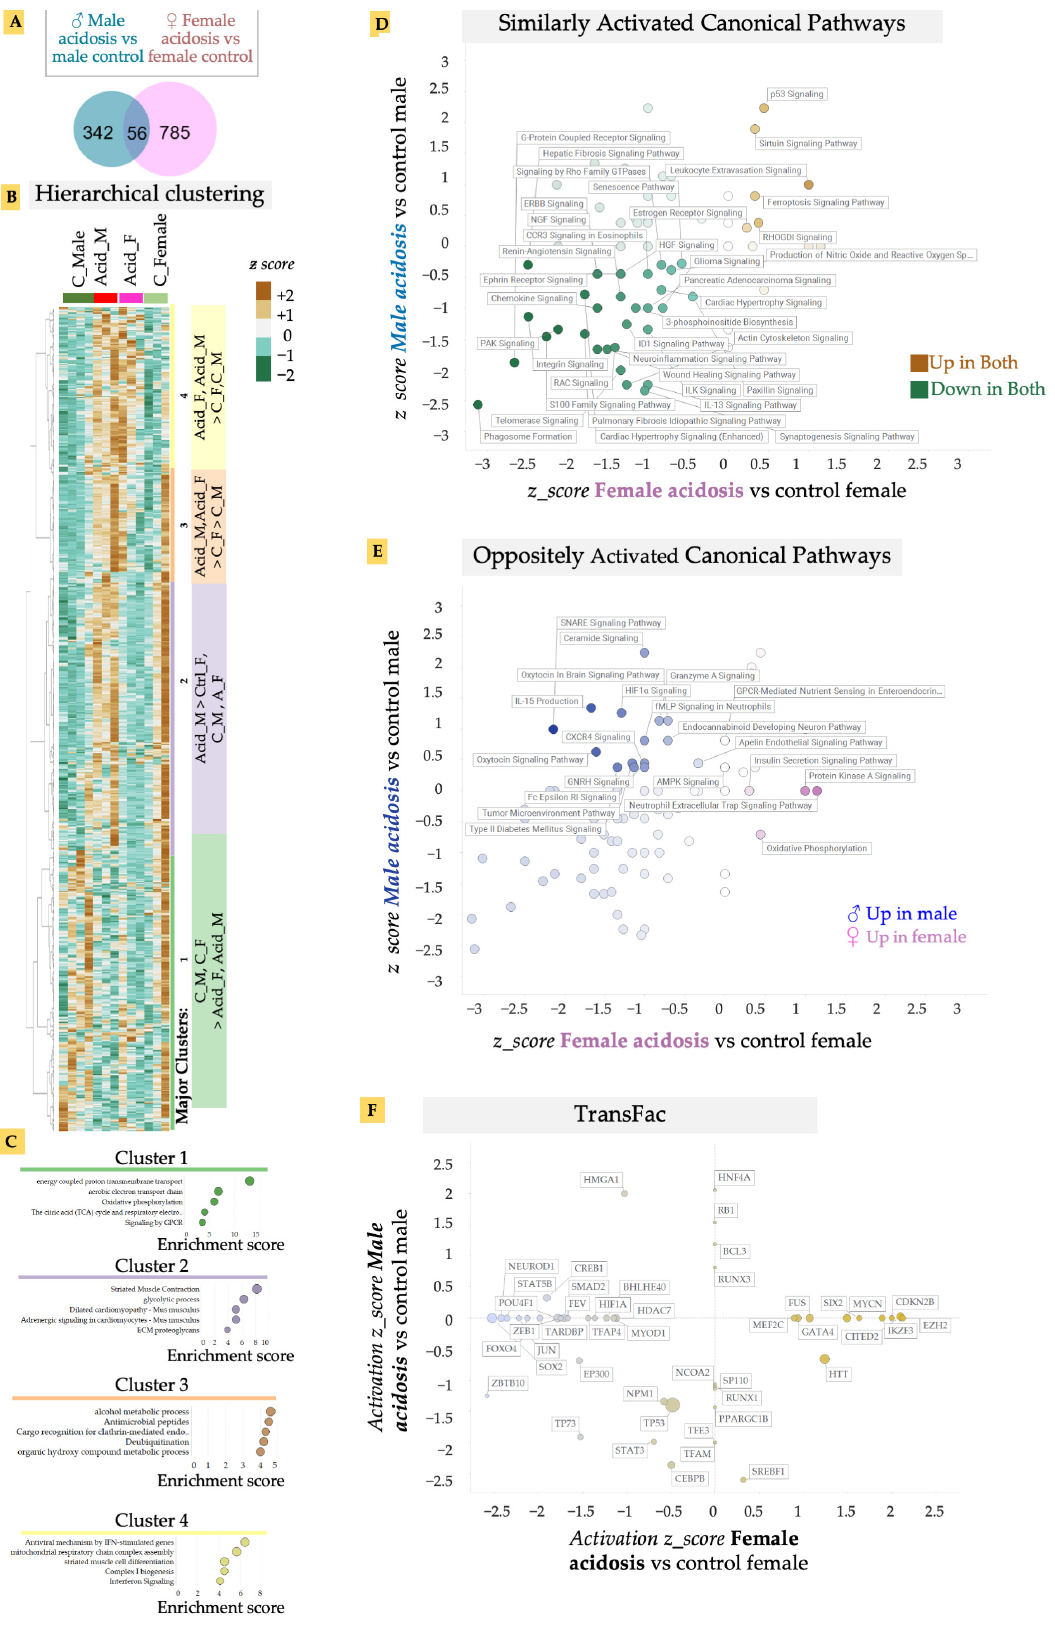
Figure 2. ( A ) Venn diagram of differentially-expressed genes in male and female acidosis heart vs. their respective controls. ( B ) Unbiased hierarchical clustering using z-scores of all